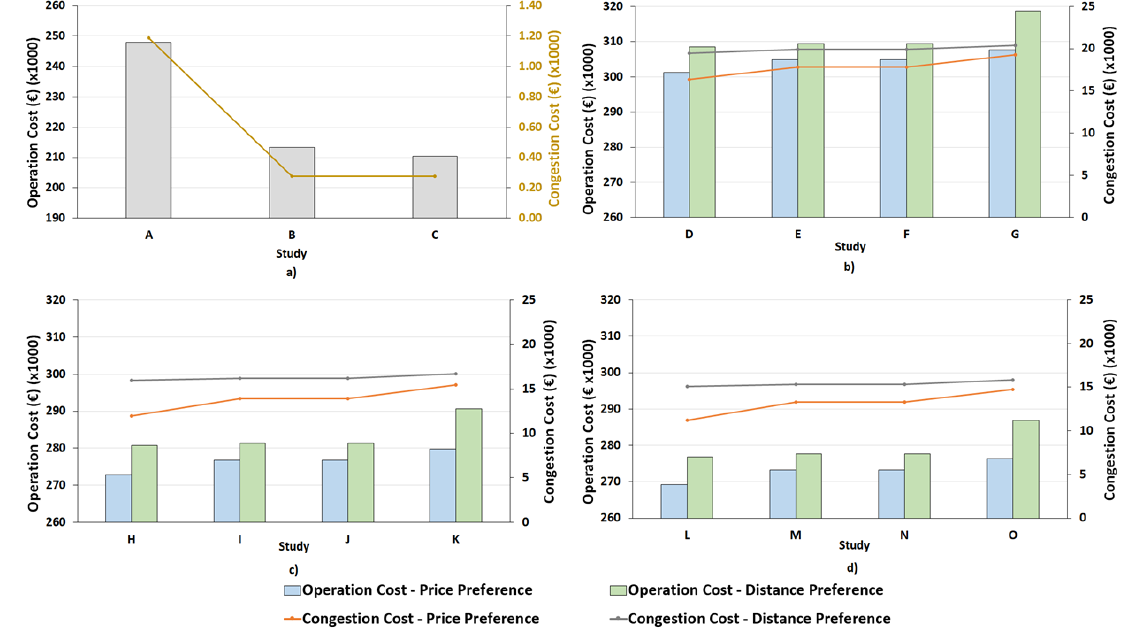
Figure 11. Total operation and congestion costs. ( a ) For cases without EVs. ( b ) For cases with EVs, but without DER. ( c ) For cases with RES, but without ESS. ( d ) For cases with DER (RES and